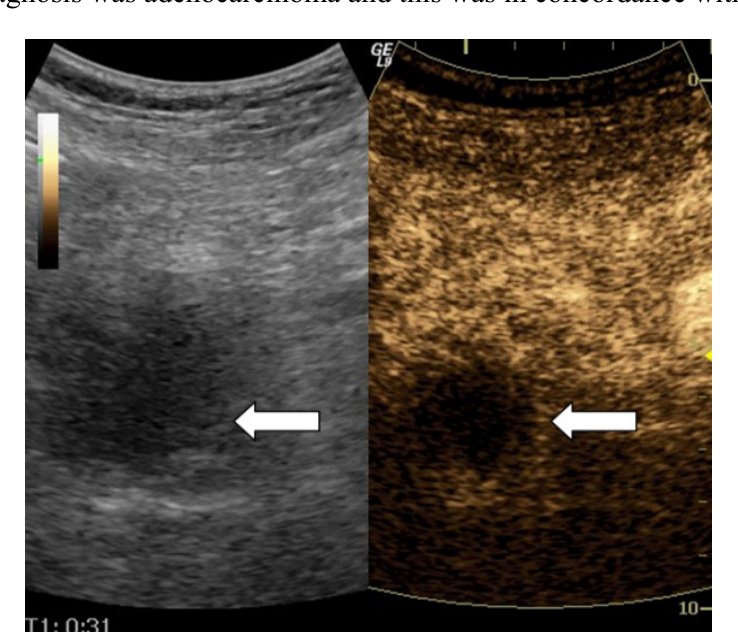
Figure 1. Dual scan image of a pancreatic lesion. B-mode image to the left and contrast image to the right. All observers agreed that this lesion was hypoenhanced. The radiological diagnosis was adenocarcinoma and this was in concordance with